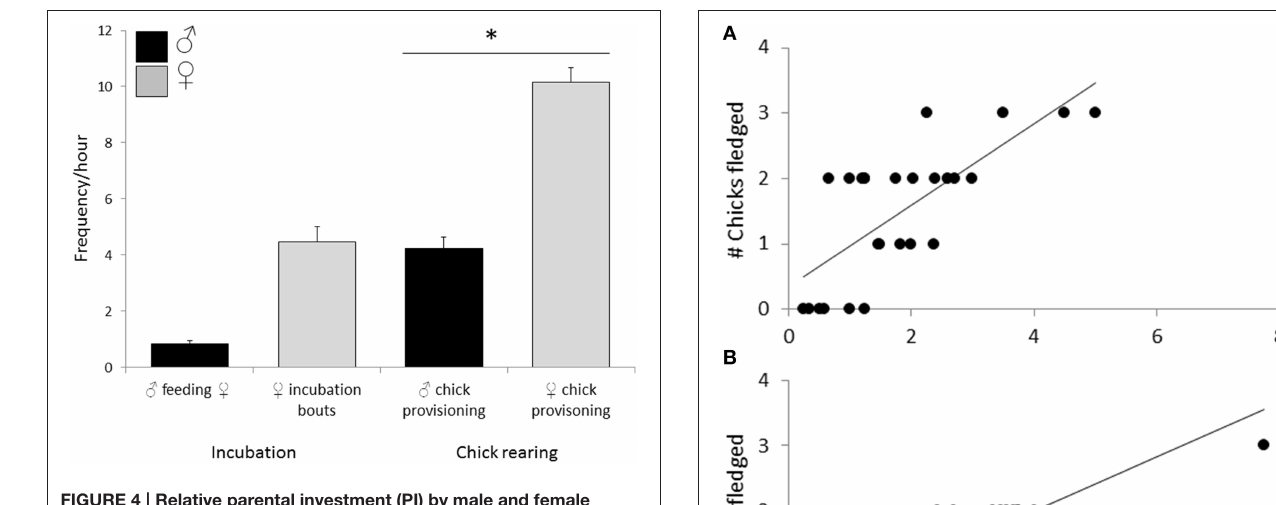
FIGURE 4 | Relative parental investment (PI) by male and female bellbirds. During incubation PI included the male feeding incubating female and female incubation bouts (16 nests, 66h). During chick-rearing PI included male and female provisioning chicks (26 nests, 116 h). Female chick provisioning rate was significantly greater than male chick-provisioning frequency ( paired t-test: t = 8.22, df = 25, P < 0.0001, indicated by * ). Only nests that hatched at least one chick were included in the analysis.